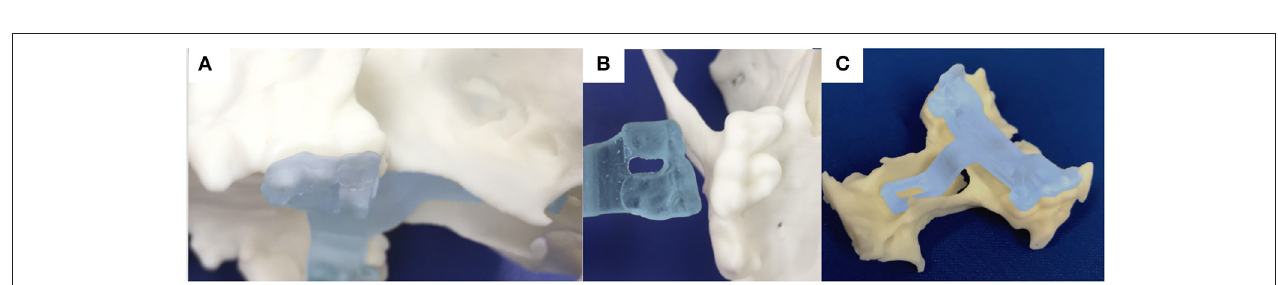
FIGURE 5 | Examples of the various iterations of the guide discussed by the authors: (A) the caudal aspect of the guide window left open; (B) placement of a slight slope at the rostral edge of the burring window to aid with burring trajectory; (C) use of a semi-opened channel to guide the bur; (D) guide offering solely a pilot hole position; (E) full channel to guide a pin and place a pilot hole; (F) final and preferred design.